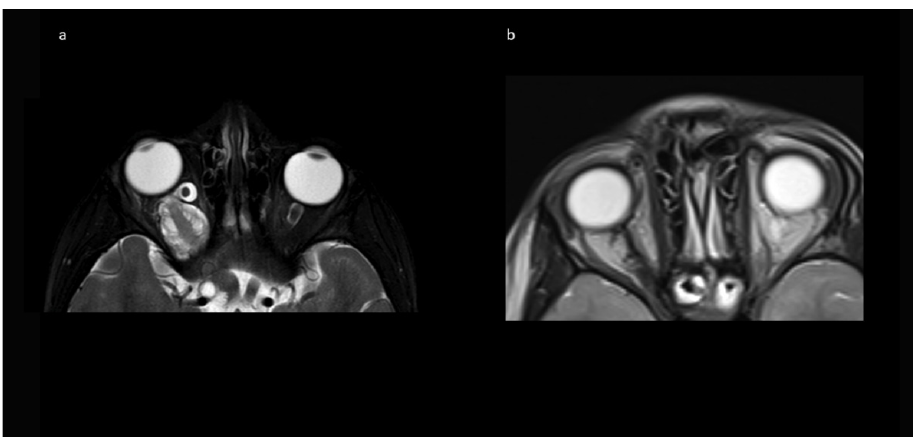
Figure 4. Exemplary MR imaging follow ‐ up of a child with ( a ) preoperative exophthalmos on the left side and ( b ) postoperative normal eye position.